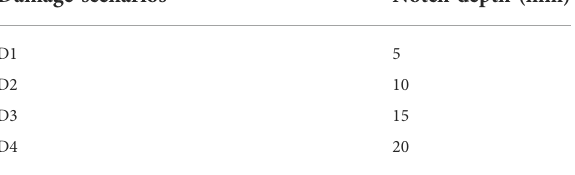
TABLE 4 Damage scenarios of steel-ECC composite deck for numerical simulation. Damage scenarios